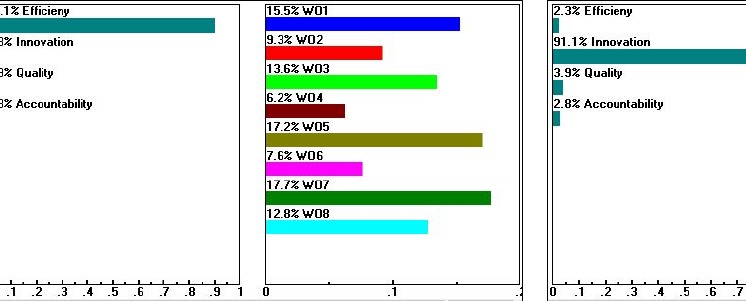
Fig. 8. Dynamic sensitivity for Innovation criteria from initial weight 0.204 (20%) to 0.911 (91.1%)